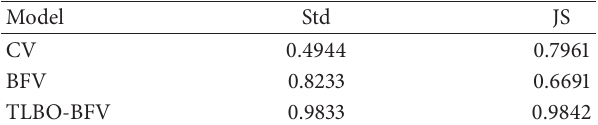
Table 2: Results of Figure 3.